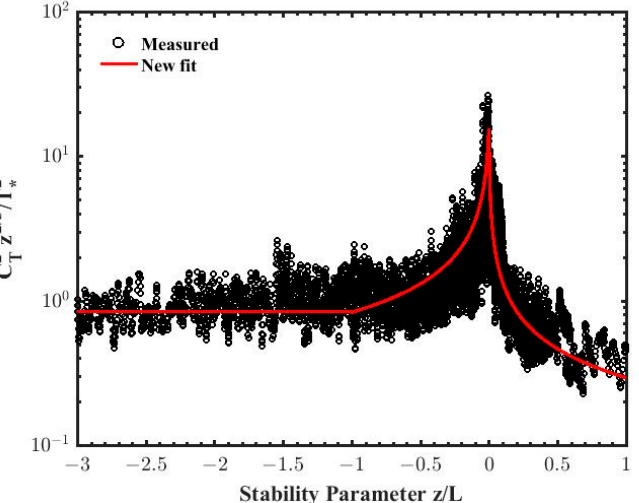
Figure 3. Dimensionless temperature structure function f T versus the stability parameter ξ = z / L .